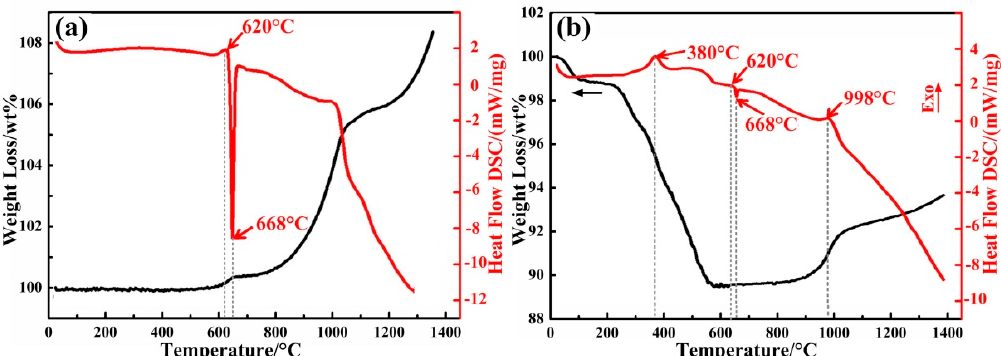
Figure 4. Differential scanning calorimetry (DSC) and thermal gravimetric analysis (TG) heating curves: ( a ) TG/DSC curves for the Al powder; ( b ) TG/DSC curves for the sample with a 15 vol % Al additive.